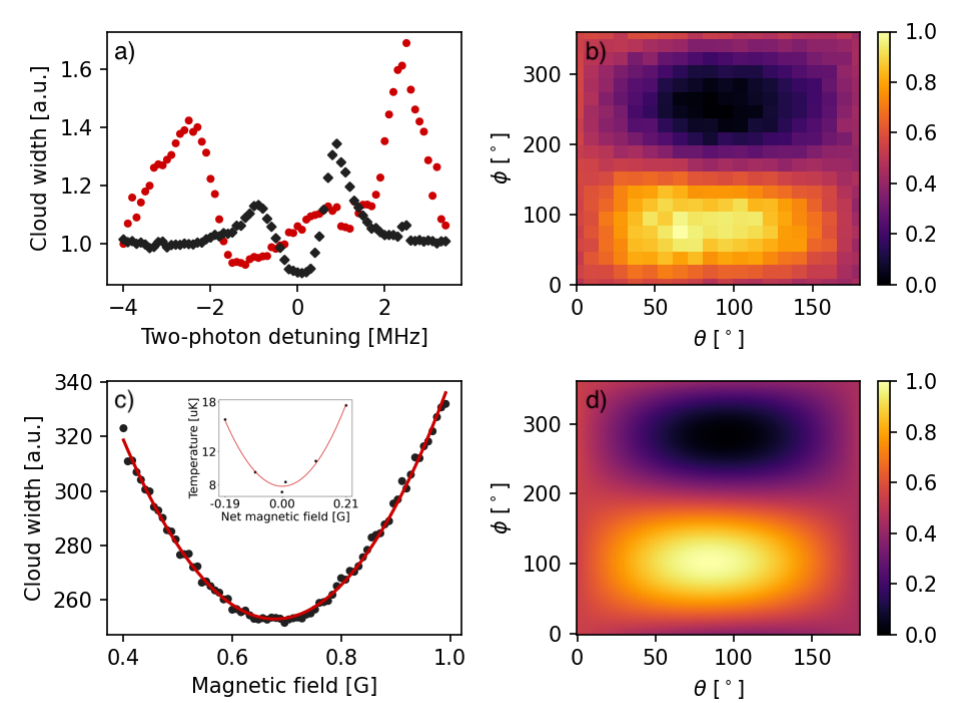
Figure 3. The horizontal width of the 39 K cloud extracted from fitting a gaussian distribution is used as a proxy of the temperature—the narrower the cloud, the colder it is. ( a ) The width normalized to the off-resonance value after gray molasses cooling for variable Raman detuning. Red dots show the initial measurements before any compensation of stray fields. The most efficient cooling (down to 32 µ K) is obtained when the repumper frequency is detuned by − 1.6 MHz with respect to the “zero gauss” two-photon condition, which is used in our compensation method. Black diamonds show an analogous measurement after stray field compensation. ( b ) The width of the cloud for various tilt angles of the magnetic field vector, measured with the amplitude of the applied magnetic field fixed at B = 0.42 G. ( c ) The width of the cloud for various magnitudes of the applied magnetic field vector for φ min = 256 ◦ and θ min = 96 ◦ . Inset: data verifying the quadratic dependence of temperature on the net magnetic field for small magnetic fields. ( d ) The predicted increase in the cloud’s temperature for the same conditions as used in ( b ) as a function of tilt angles. The plot is in qualitative agreements with observations shown in ( b ). The color scale in ( b , c ) is normalized such that 0 and 1 correspond the minimum and maximum widths of the cloud,